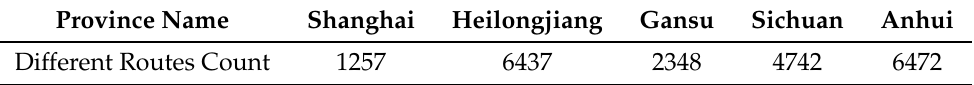
Table 5. Non-duplicate routes count. Statistical results of non-duplicated paths in different regions. Heilongjiang and Anhui Province have the largest number of routes, and Shanghai has the least number of